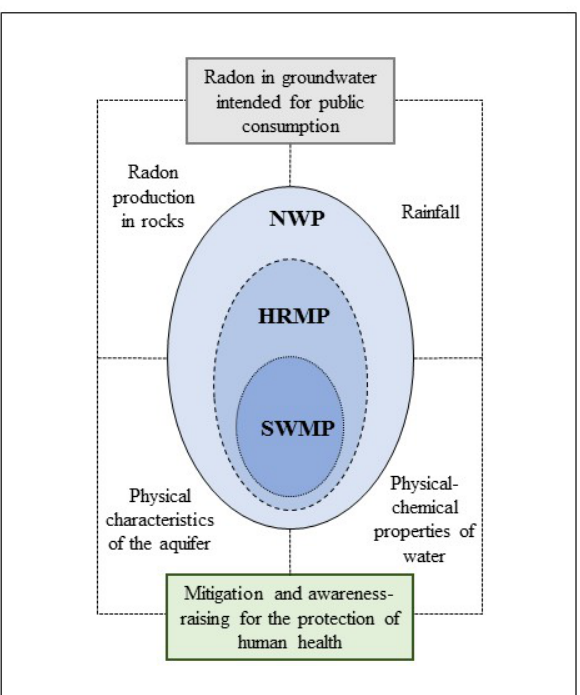
Figure 2. Technical workflow specifically designed to implement a Portuguese Action Plan for radon (PAPR) in aquifers systems. NWP is the National Water Plan, HRMPs are the Hydrographic